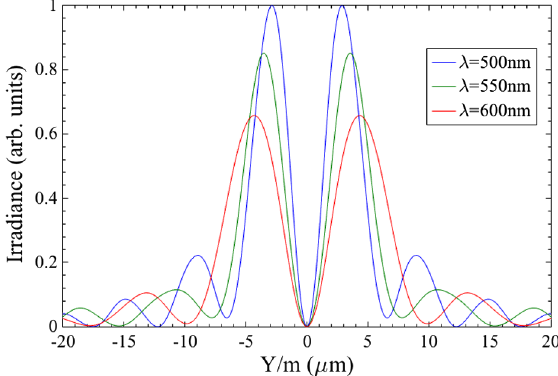
FIG. 5. OTR PSF distribution simulated by ZEMAX for γ ¼ 2500